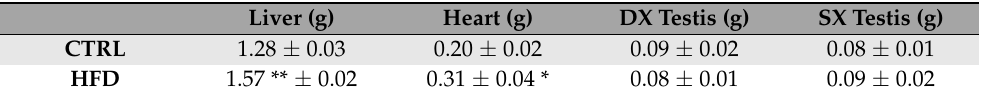
Table 1. Effects of HFD on body components. Data are expressed relative to the CTRL group and reported as mean ± SEM; * p < 0.05; ** p < 0.01. Liver (g) Heart (g) DX Testis (g) SX Testis (g) CTRL 1.28 ± 0.03 0.20 ± 0.02 0.09 ± 0.02 0.08 ± 0.01 HFD 1.57 ** ± 0.02 0.31 ± 0.04 * 0.08 ± 0.01 0.09 ± 0.02